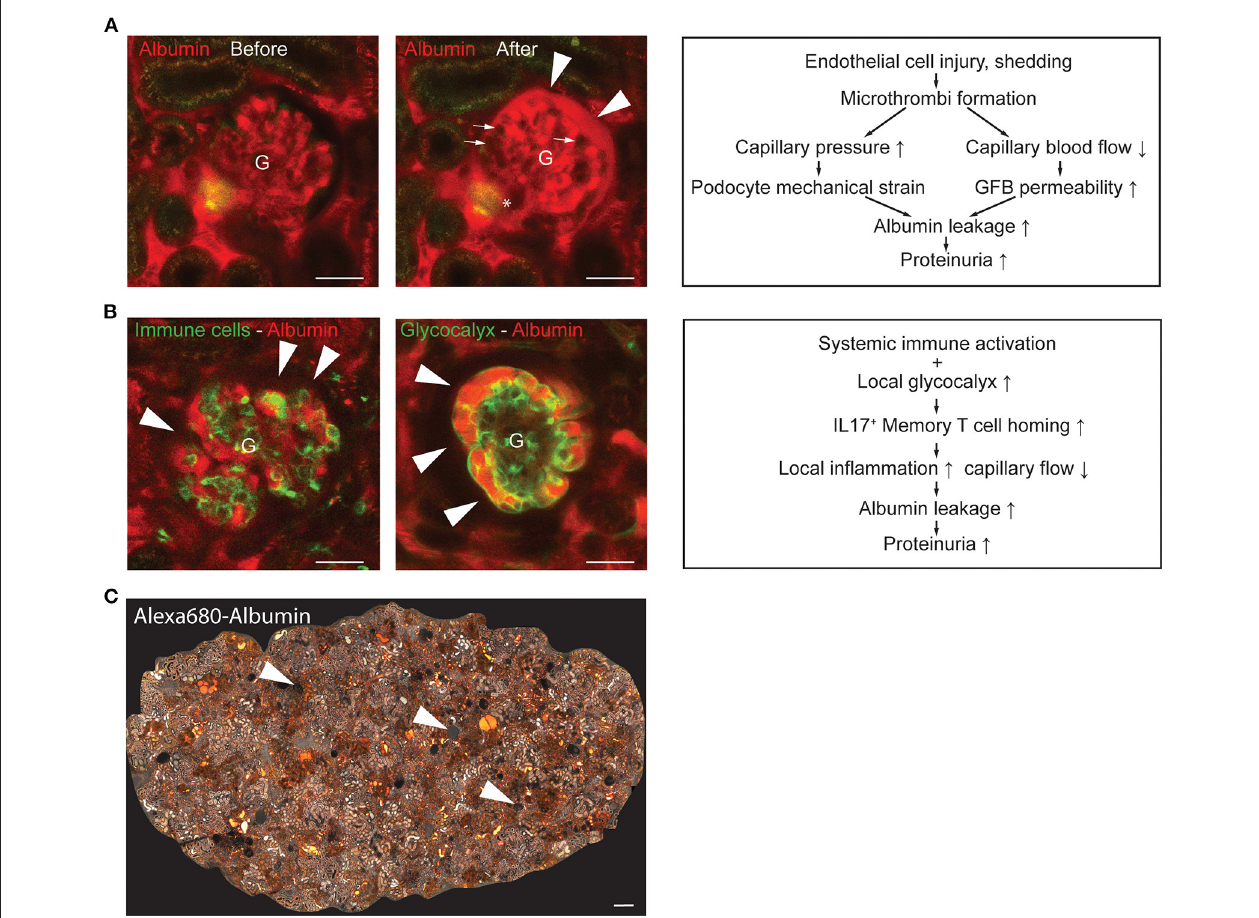
FIGURE 2 | Representative intravital MPM images of glomerular endothelial injury models and schematics of their underlying pathogenic mechanisms. (A) Laser-induced injury of GEnCs [injury site indicated by an asterisk (*)] triggered microthrombi formation in several glomerular capillary segments [dark, excluding the plasma marker Albumin-Alexa Fluor 594 (red), indicated by arrows] and robust albumin leakage into the Bowman’s space (arrowheads). Note the normal flow of red blood cells (dark, plasma excluding) in glomerular (G) capillaries before GEnC laser injury (left panel), and the blockade of red blood cell passage due to microthrombi with only reduced plasma flow (intense red) in glomerular capillaries after laser injury (middle panel). The “after” image of the same glomerulus was acquired 1min following the “before” image; the entire video sequence starting at the end of laser injury is shown in Supplementary Video 1 available at https://figshare.com/s/ 0ca6f8d0dae48415ca01. Schematic illustration of the mechanisms involved in the development of GEnC injury-induced albumin leakage and proteinuria development (right panel). (B) Representative in vivo MPM images of the NZM.2328 BAFF transgenic mouse model of lupus nephritis (LN). Endogenous circulating CD44 + immune cells were labeled with iv injected anti-CD44-Alexa Fluor 488 antibodies (green) and the circulating plasma albumin with Alexa Fluor 594 (red) (left panel). Note the leakage of plasma albumin into the Bowman’s space (arrowheads) based on the light red color of the Bowman’s space in contrast to the dark (albumin-free) Bowman’s space shown in panel A above. Alternatively, the GEnC glycocalyx was labeled by iv injected FITC-WGA (green, arrowheads) (middle panel). Schematic illustration of the mechanisms involved in glomerular immune cell homing and proteinuria development in LN (right panel). (C) Representative tile scan image of the entire superficial cortical area of an 8-months old NZM.2328 mouse kidney injected with Albumin-Alexa Fluor 680 iv (shown in grayscale) illustrating the complexity of LN pathologies. These include glomerular albumin leakage (arrowheads, based on the light gray color of the Bowman’s space), high albumin-containing tubule segments (intense white), and several focal fibrotic interstitial areas (lack of glomerular or tubular structures). Bars are 50 µ m in (A,B) and 100 µ m in (C)